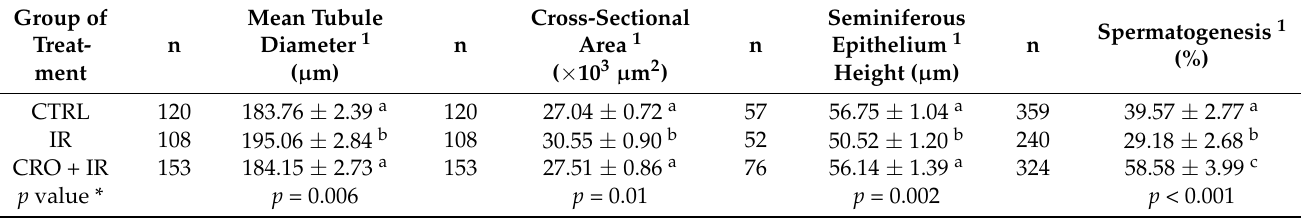
Table 1. Morphometric parameters in pubertal testis exposed to IR in the presence/absence of